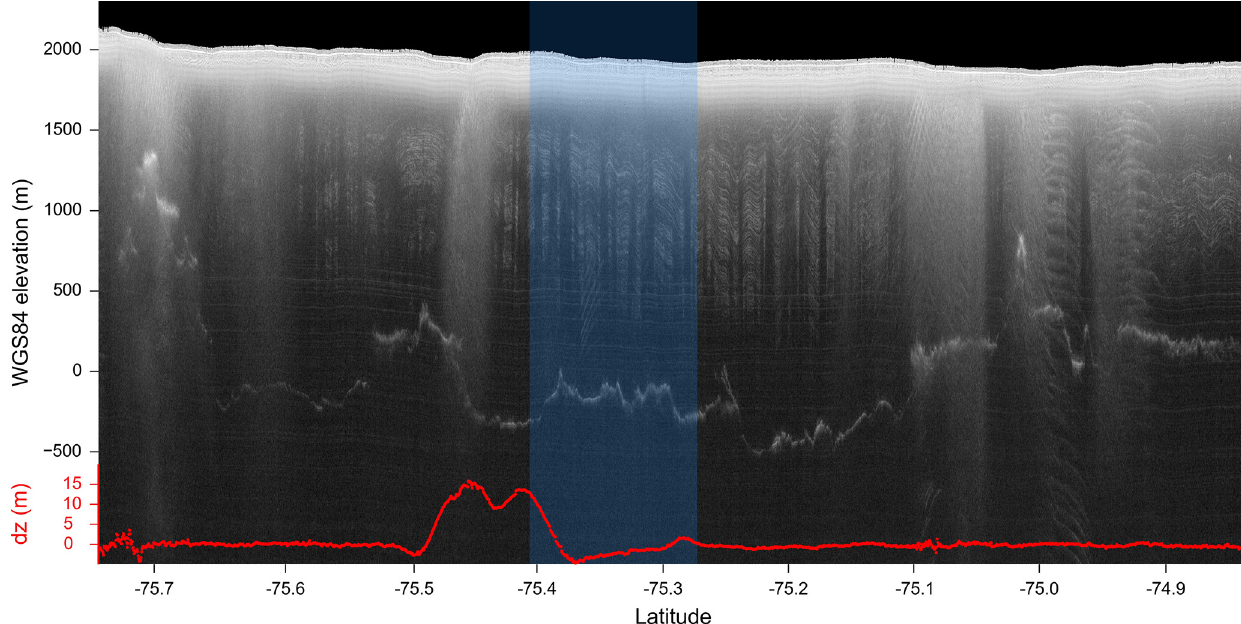
Figure 3. Focused radargram DVG/IBH0c/GL0328c. The location of the transect is shown in Fig. 7, and its overlap with the D2 lake outline is highlighted in blue. Observed surface elevation change since 2003 is shown in red. The radargram has been depth-corrected based on laser surface elevations and truncated 20m above the